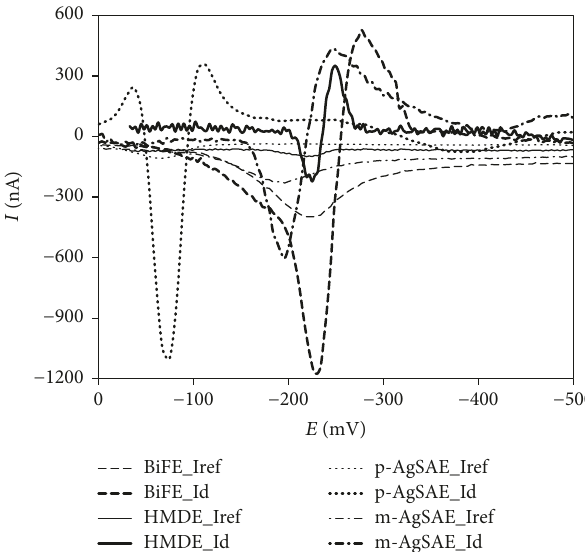
Figure 4: Elimination voltammograms of DAN recorded on tested electrodes. 𝑐 = 5.0 × 10 −6 molL −1 . DC curves registered under DAN optimized conditions. Elimination functions calculated from scan rate set: 50, 100, 200, and 400mV s −1 . 𝐼 : 200 mVs −1 , 𝐼 𝑑 : ref